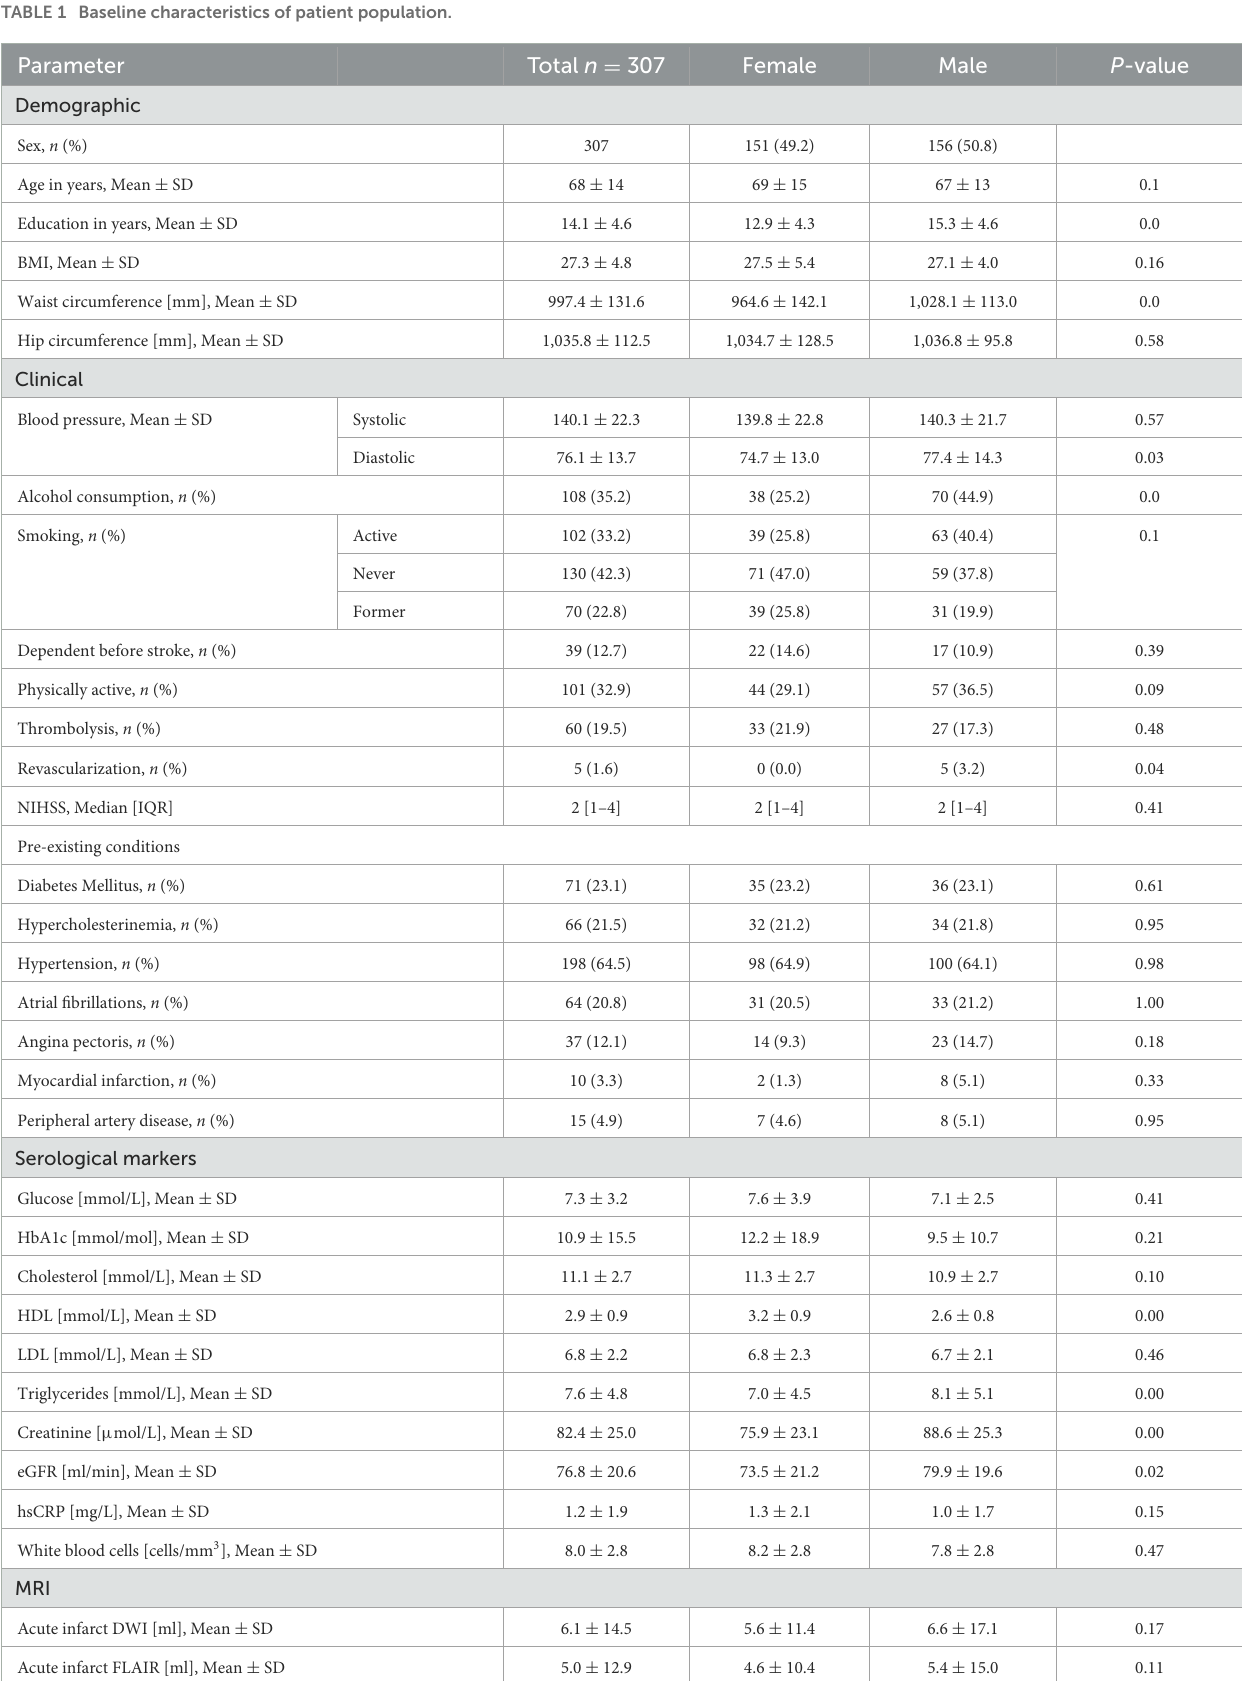
TABLE 1 Baseline characteristics of patient